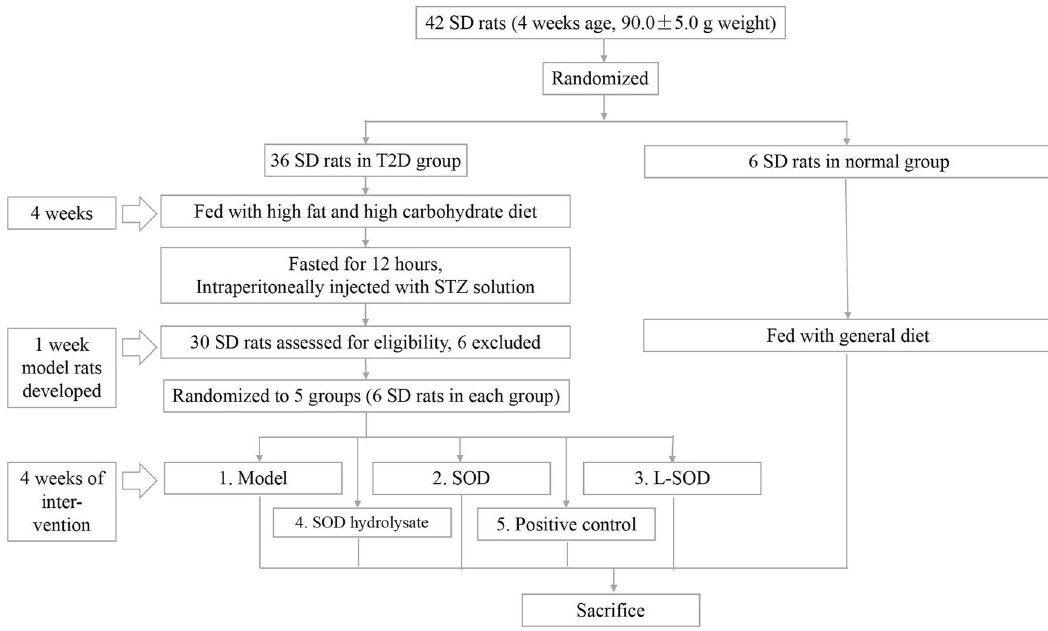
Fig. 11 Study fl ow chart. Development, grouping, and intervention of T2D model